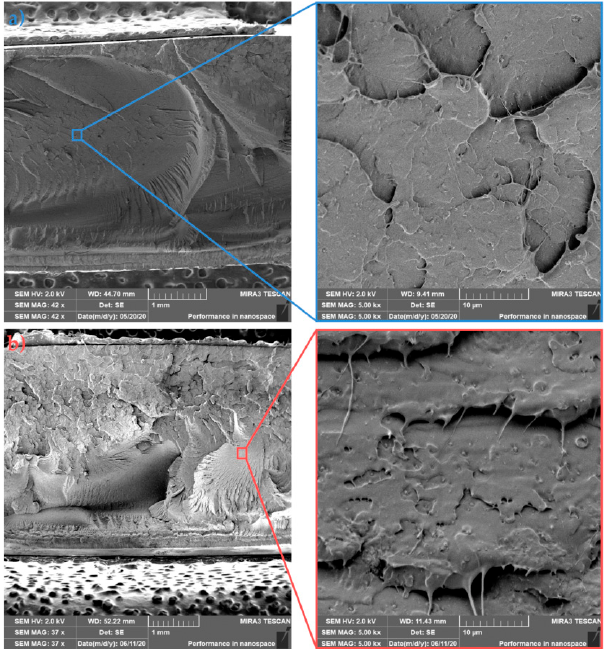
Figure 11. Fracture morphologies of ( a ) cold and ( b ) hot mold PLLA/1HA.